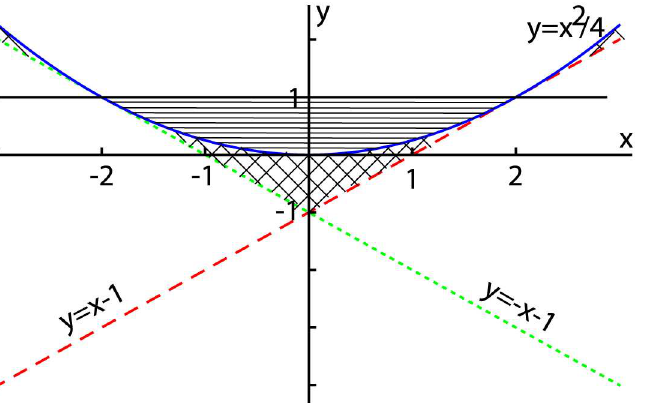
Fig 7. Stability regions of the two-dimensional recursive maps. The stability conditionfor any recursive maps requiresthat all roots of the characteristic polynomialare less than unit (| λ | < 1). For a